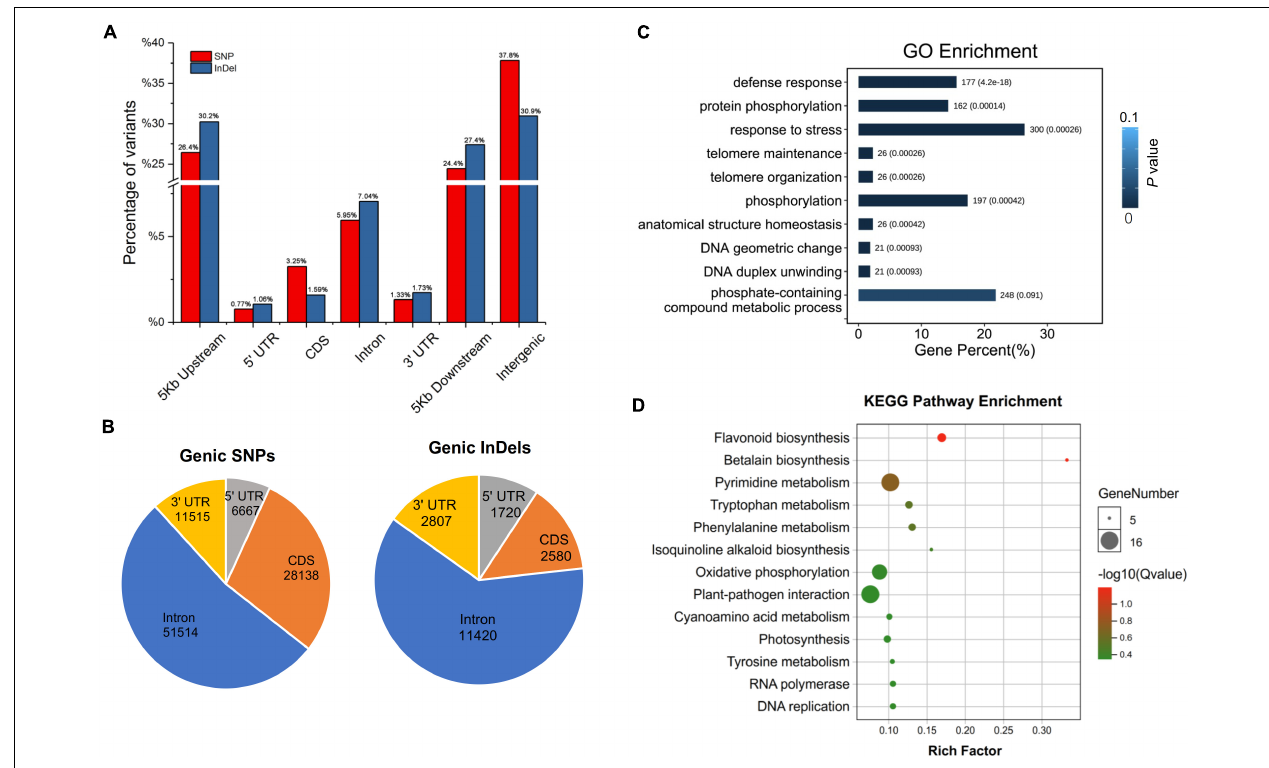
FIGURE 3 | Annotation and functional enrichment analysis of “SSR41” genome variations. (A) Distribution of SNPs and InDels at the whole genome level. (B) Distribution of SNP and InDels in genic regions. (C) Gene ontology enrichment analysis of genes with large-effect variations. (D) Kyoto Encyclopedia of Genes and Genomes pathway enrichment analysis of genes with large-effect